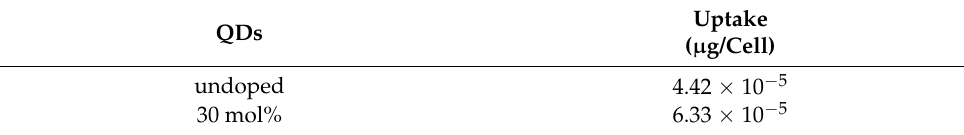
Table 5. Uptake of Cs 3 Bi 2 Cl 9 and Cs 3 Bi 2 Cl 9 : Ce 30% QDs by HepG2 cells.